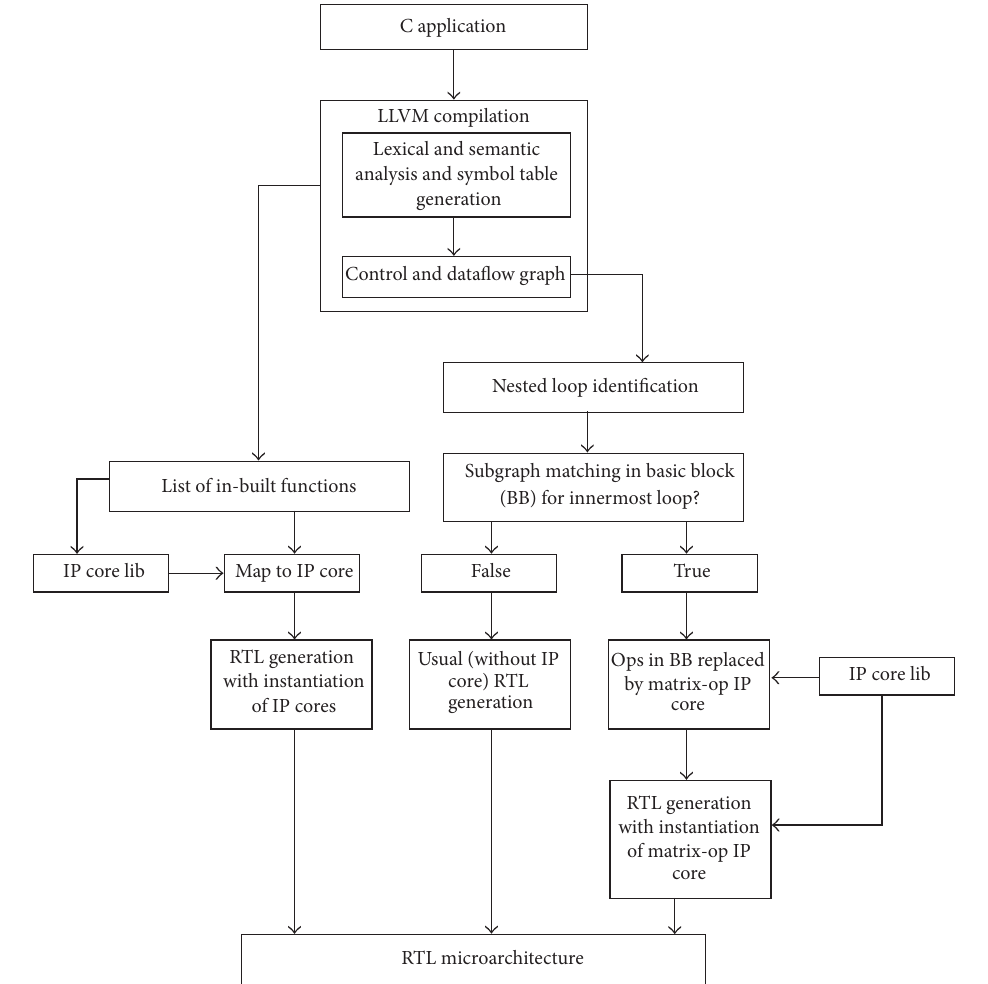
Figure 1: Proposed IP-enabled C/C++ HLS flow.